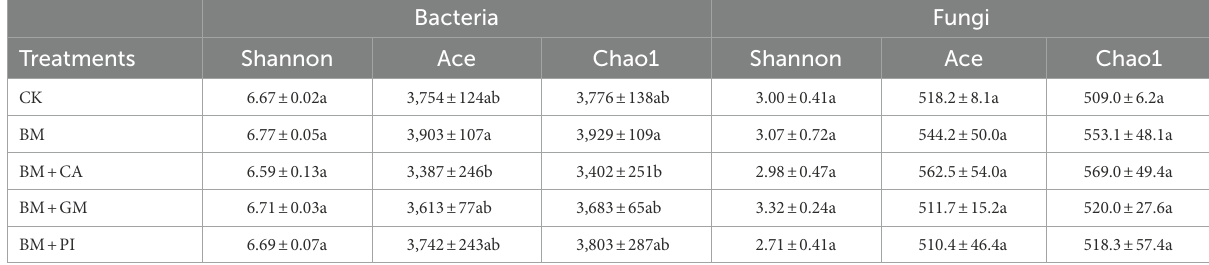
TABLE 1 Diversity indexes of bacteria and fungi in different treatments. Bacteria